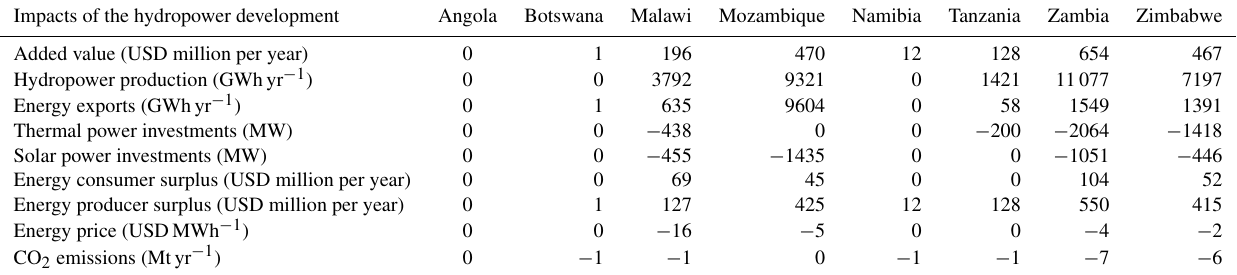
Table 11. Country-scale impacts of the hydropower development plan. Results are shown as the difference with and without the hydropower development plan for the 2030 scenario. The added value excludes construction costs. Impacts of the hydropower